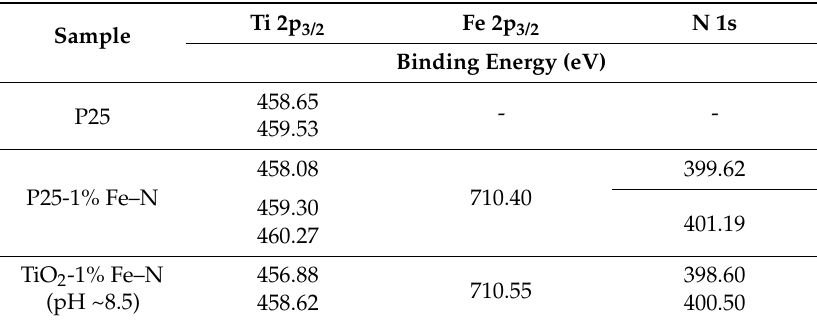
Figure 2. The X-ray photoelectron spectroscopy (XPS) spectra recorded on P25 TiO 2 ( A ); P25-1% Fe–N ( B ); and TiO 2 -1% Fe–N (pH ~8.5) ( C ) samples. Table 2. The binding energy values extracted from the deconvolutions of the X-ray photoelectron spectroscopy (XPS) spectra.